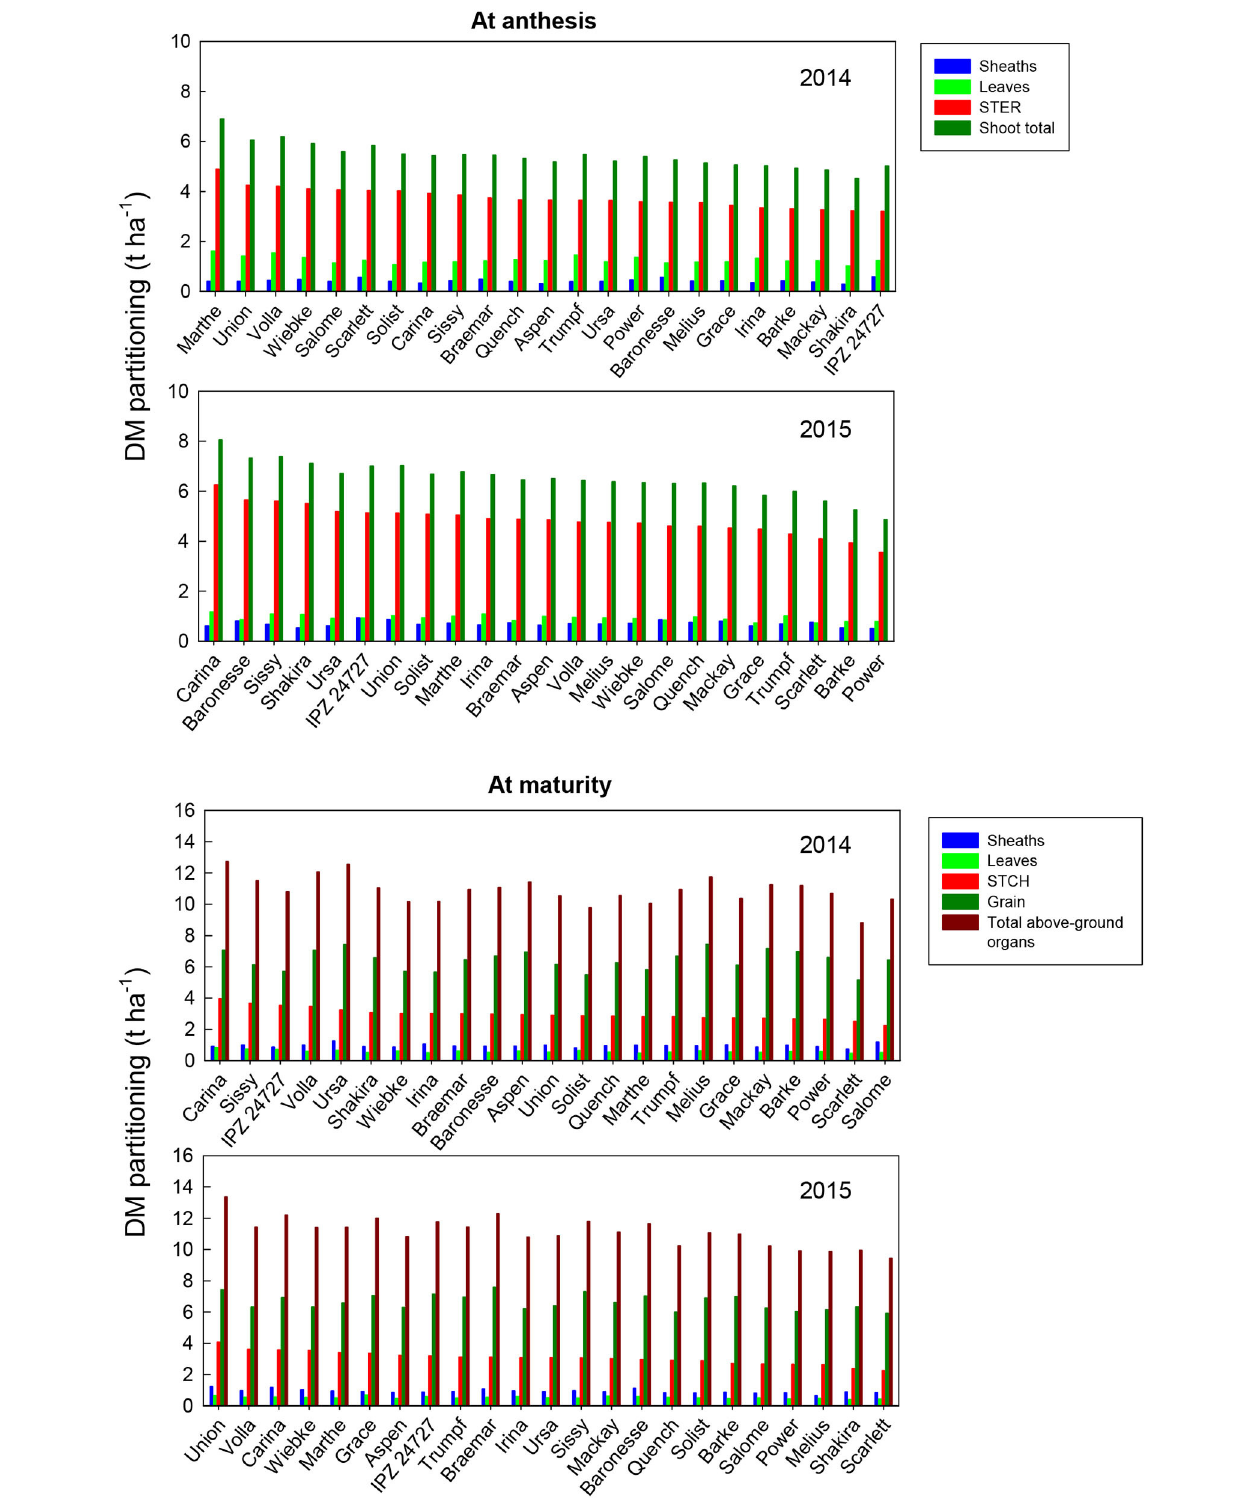
FIGURE 2 | Dry matter partitioning in different organs: dry matter (DM) accumulation (t ha − 1 ) of different plant organs of the 23 spring malting barley varieties at anthesis and maturity under recommended N fertilization conditions in 2014 and 2015, ranked on STER DM at anthesis or STCH DM at maturity. Mean comparisons among the varieties from Tukey’s honestly significant difference (HSD) test are shown in Supplementary Tables 1 and 3 .